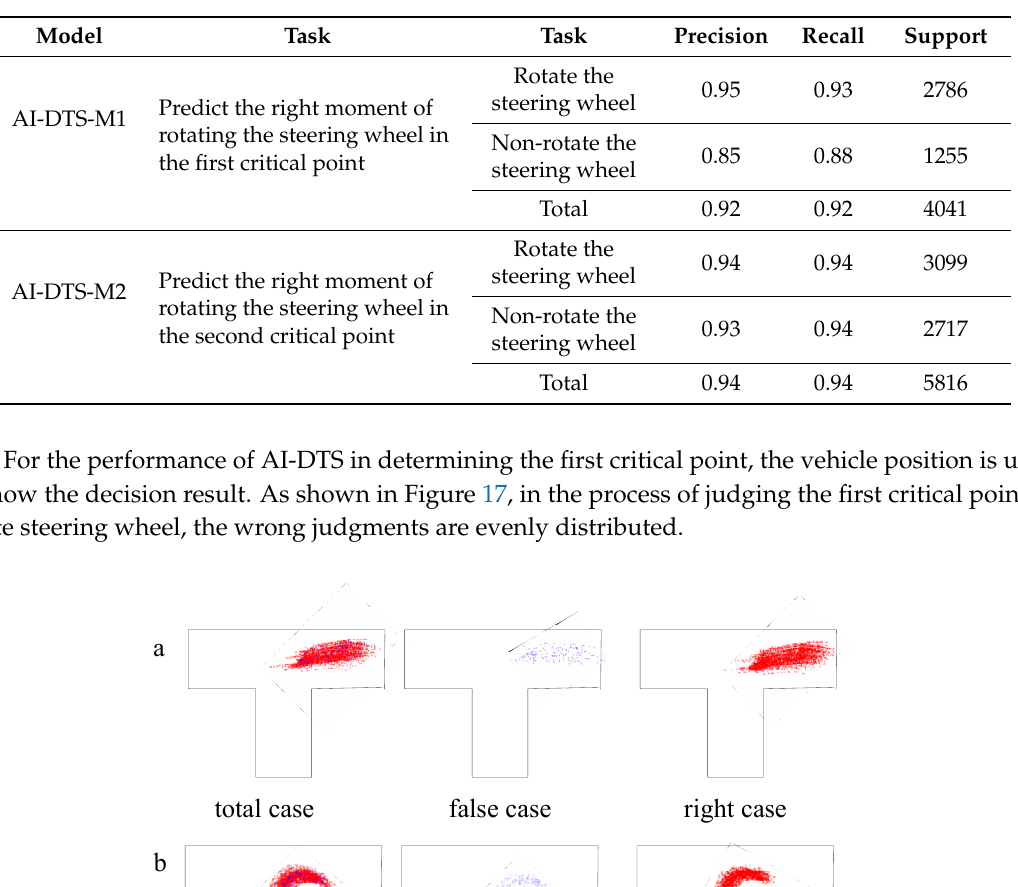
Table 1. The performance of the AI-DTS.